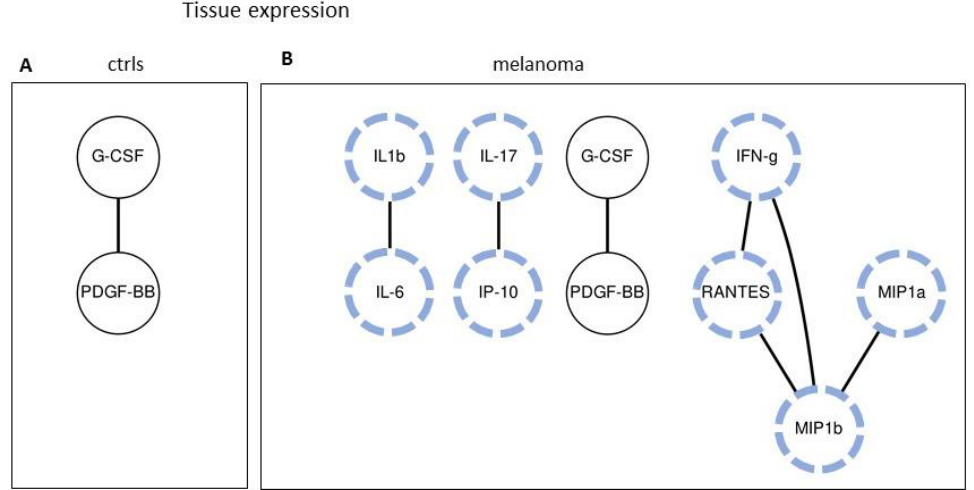
Figure 6. Correlation analysis of the tissue expression values of all the control ( A ) and melanoma ( B ) samples. The connected circles show the paired molecules with a p < 0.05 and Spearman’s R coefficient > 0.70, in the control and melanoma samples, respectively. The correlations specifically present in the melanoma samples are highlighted with blue dashed